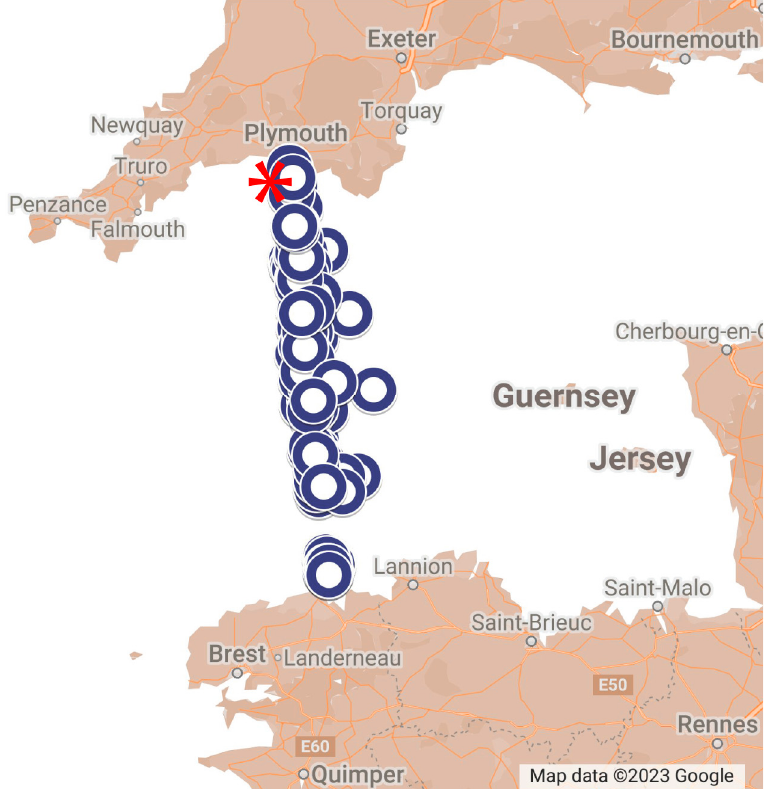
Figure 1. WaMS sampling positions in the Western Channel from 2011 to 2013 deployed within the CPR device on the PR route from Roscoff to Plymouth. Asterix shows the approximate location of station WCO L4.